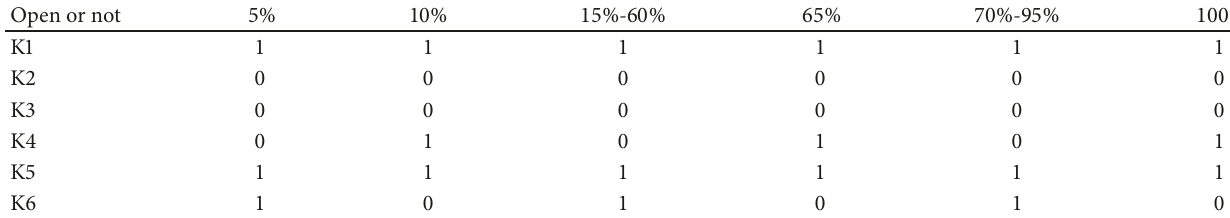
Table 21: Impact of capacity’s ST in shredders.